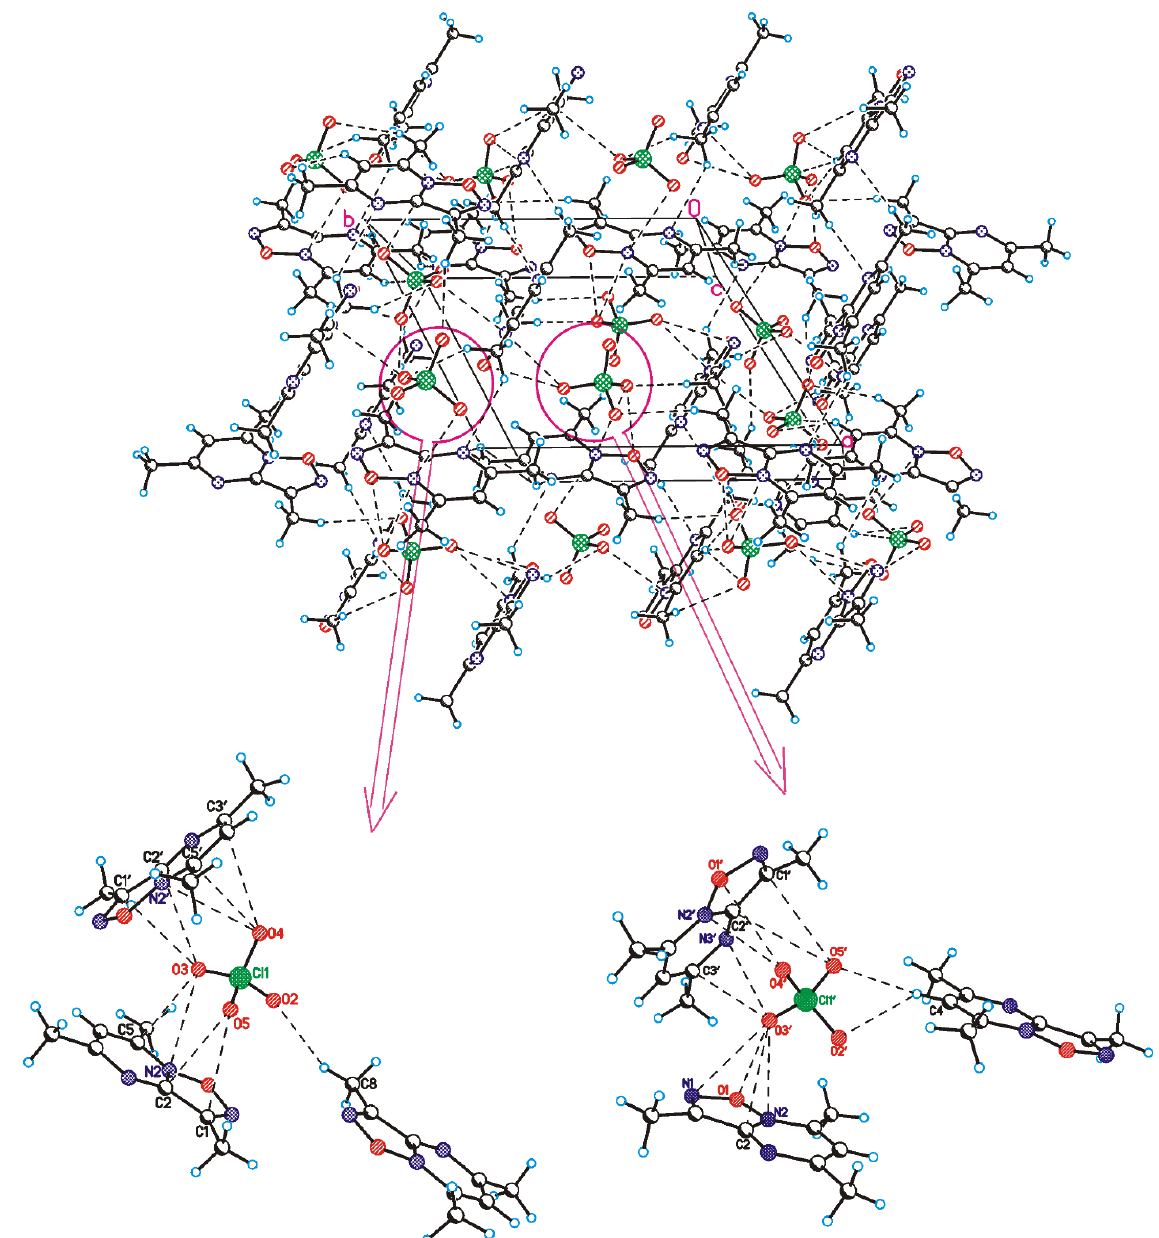
Figure 5. Crystal packing fragment of compound 10a . C – H…N cation … cation and C – H … O and O … π anion … cation interactions are shown by dashed lines. Detailed view of anion … cation interactions is provided at the bottom. Minor part of the disorder is omitted for clarity.